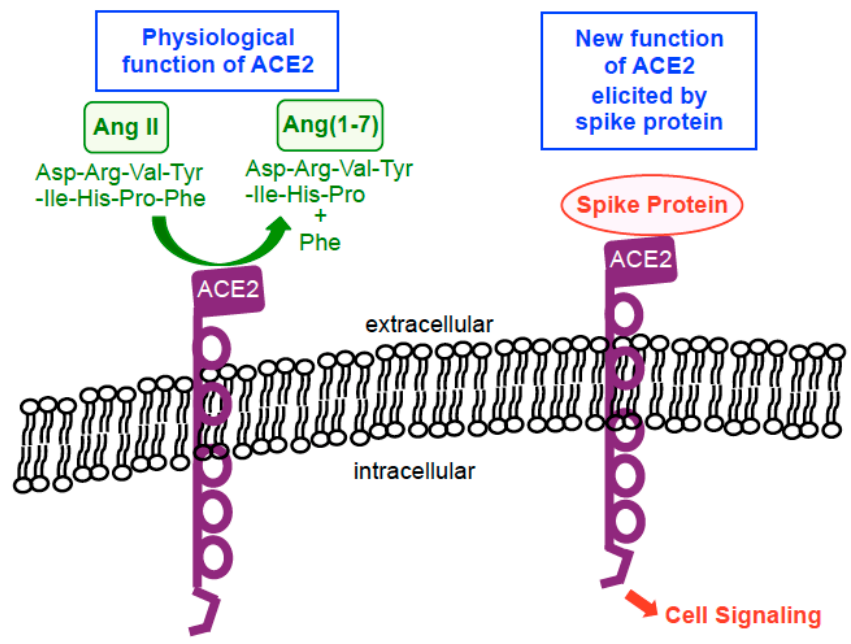
Figure 2. Biological functions of ACE2. In physiological situations, ACE2 functions as a carboxypeptidase enzyme that catalyzes the hydrolysis of angiotensin II (Ang II) into Ang(1–7) by cleaving off a phenylalanine (Phe). In the presence of the spike protein, this enzyme becomes a membrane receptor for cell signaling that uses the spike protein as a ligand for its activation.